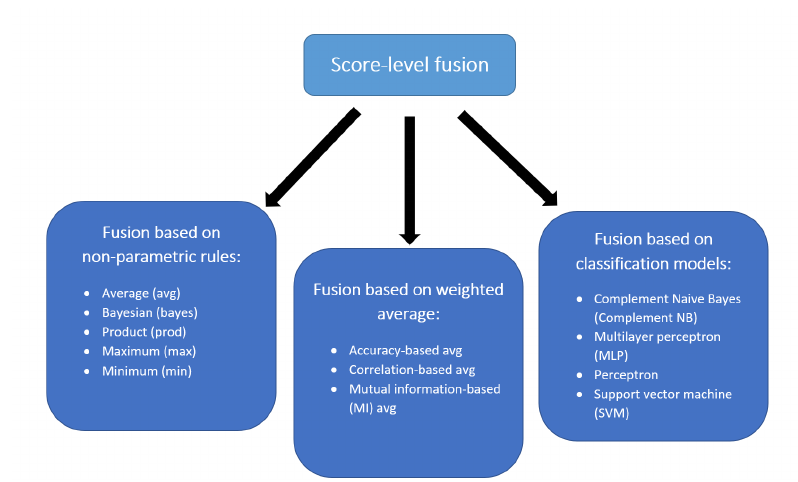
Figure 2. Taxonomy of the analyzed score-level fusion